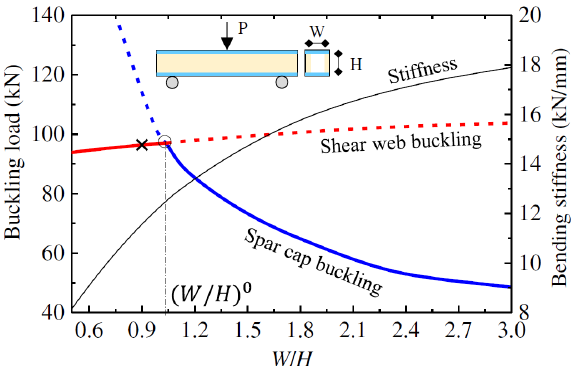
Figure 13. Buckling mode map of GFRP composite box beam with different cross-sectional aspect ratios, where the spar cap is the flange, ×is the baseline design, and O is the desired design [108].